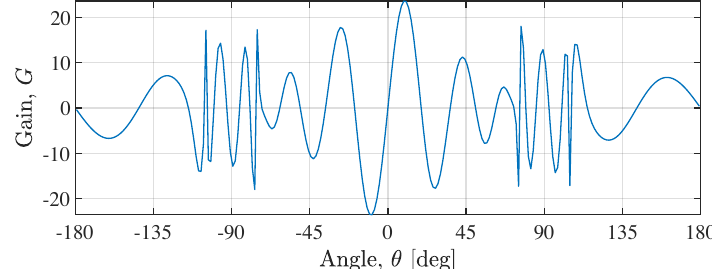
Figure 11. Gain for the pressure on the surface. The angle θ takes zero at the right edge of the